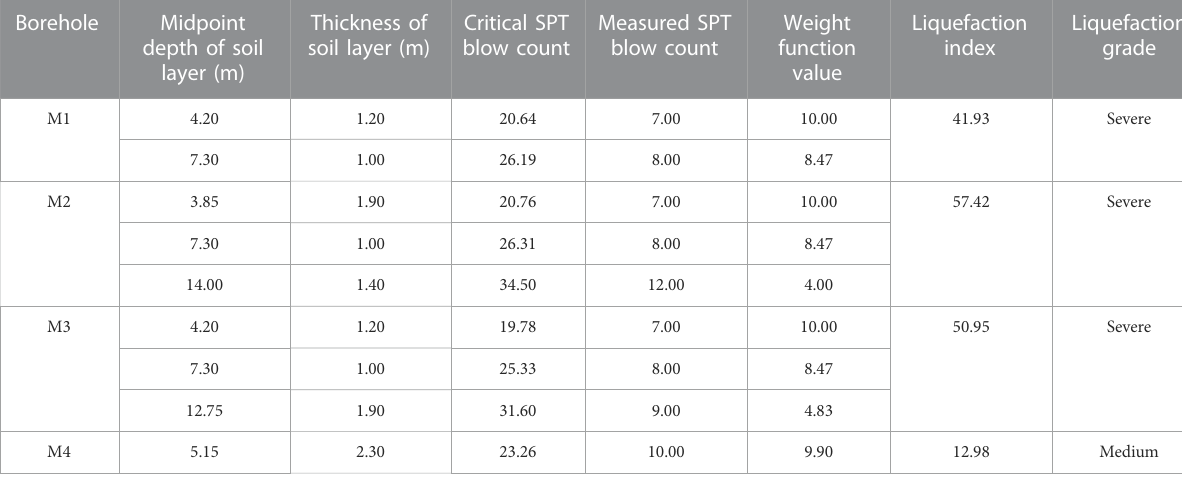
TABLE 2 Liquefaction susceptibility of port by SPT.